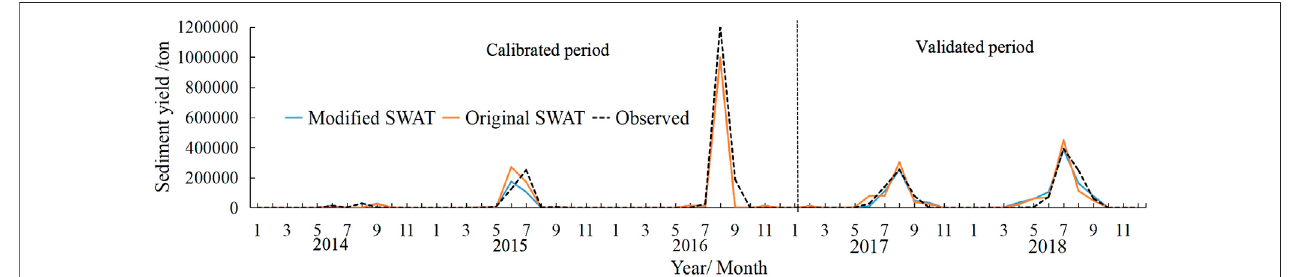
FIGURE 9 | The monthly sediment yield simulated by the original and modi fi ed Soil and Water Assessment Tool (SWAT) models compared to the that of observed sediment yield.